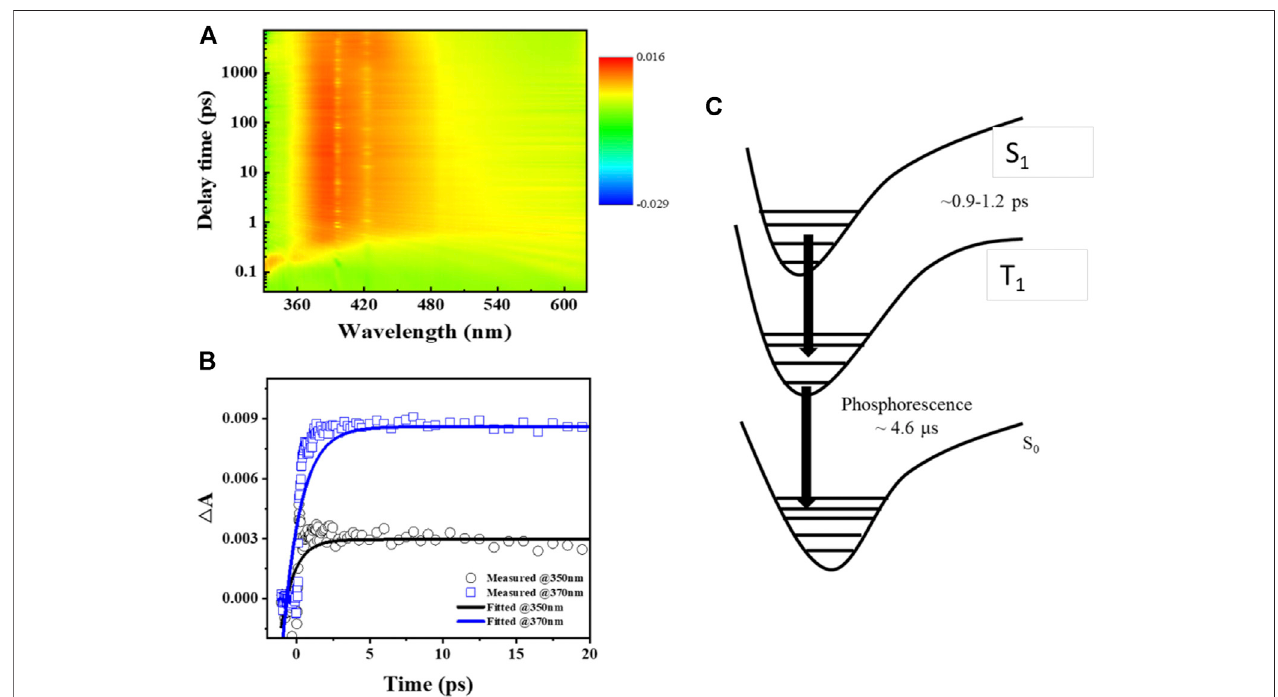
FIGURE 3 | (A) Color plot of femtosecond transient absorption spectra of Ir-dfpMepy-CN in DCM at room temperature, (B) transient absorption kinetics of 350 and 370 nm, (C) schematic illustration of excited-state dynamics occurring in Ir-dfpMepy-CN . (The decay data in Figure 3B were fi tted by a single-term exponential decay model: y ( t ) (cid:1) A 0 p exp (cid:4) − t τ (cid:5) , where τ is the decay time and A 0 is a constant).